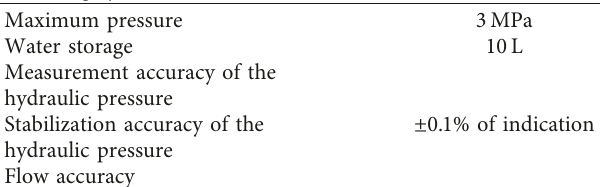
Table 2: Main technical parameters of the hydraulic pressure stabilizing